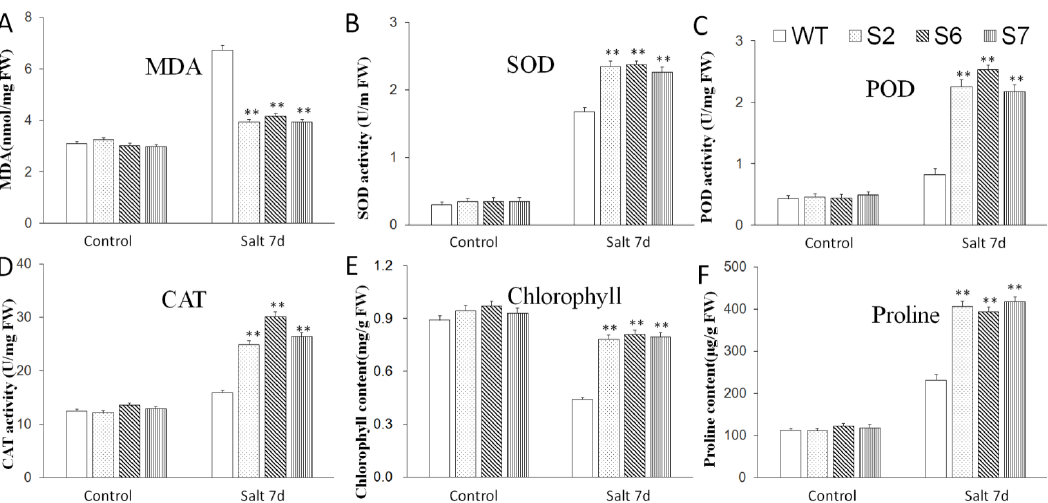
Figure 8. Effects of overexpression of VvWRKY28 on physiological and biochemical indexes of A. thaliana under high salt conditions. ( A ) MDA content; ( B ) SOD activity; ( C ) POD activity; ( D ) CAT activity; ( E ) Chlorophyll content; ( F ) Proline content. The standard error was the average of 3 repeated tests. The asterisk above the column indicated that there was a very significant difference between the transgenic lines and the WT lines, **, p ≤ 0.01 .